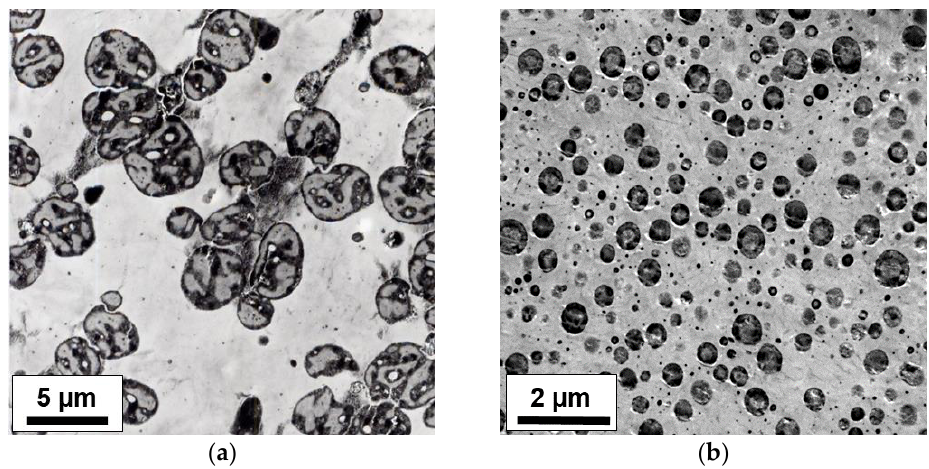
Figure 12. Phase morphology overview of special HECOs from the Borstar ® PP process: ( a ) reactor- based thermoplastic polyolefin (RTPO) with bimodal EPC having significant crystalline fraction (XCS: 32 wt.-%) and ( b ) RAHECO with random propylene copolymer matrix (4 wt.-% C2) and 15 wt.% EPC (total XCS: 22 wt.-%).